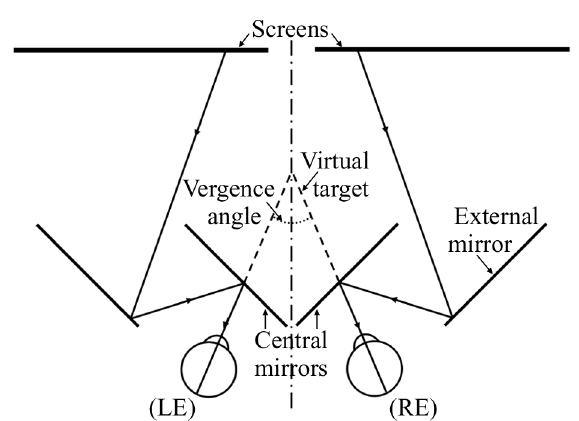
Figure 1. Schema of the stereoscope. A target was displayed on each of two screens. Owing to binocular fusion, the subject perceived a single virtual